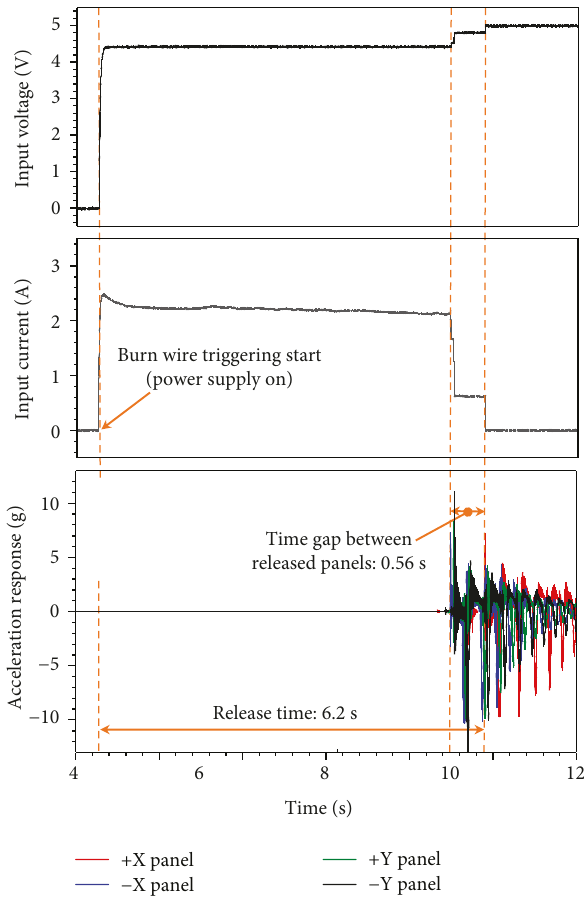
Figure 9: Time pro fi les of the input voltage and current of the mechanism and acceleration responses of the solar panels.